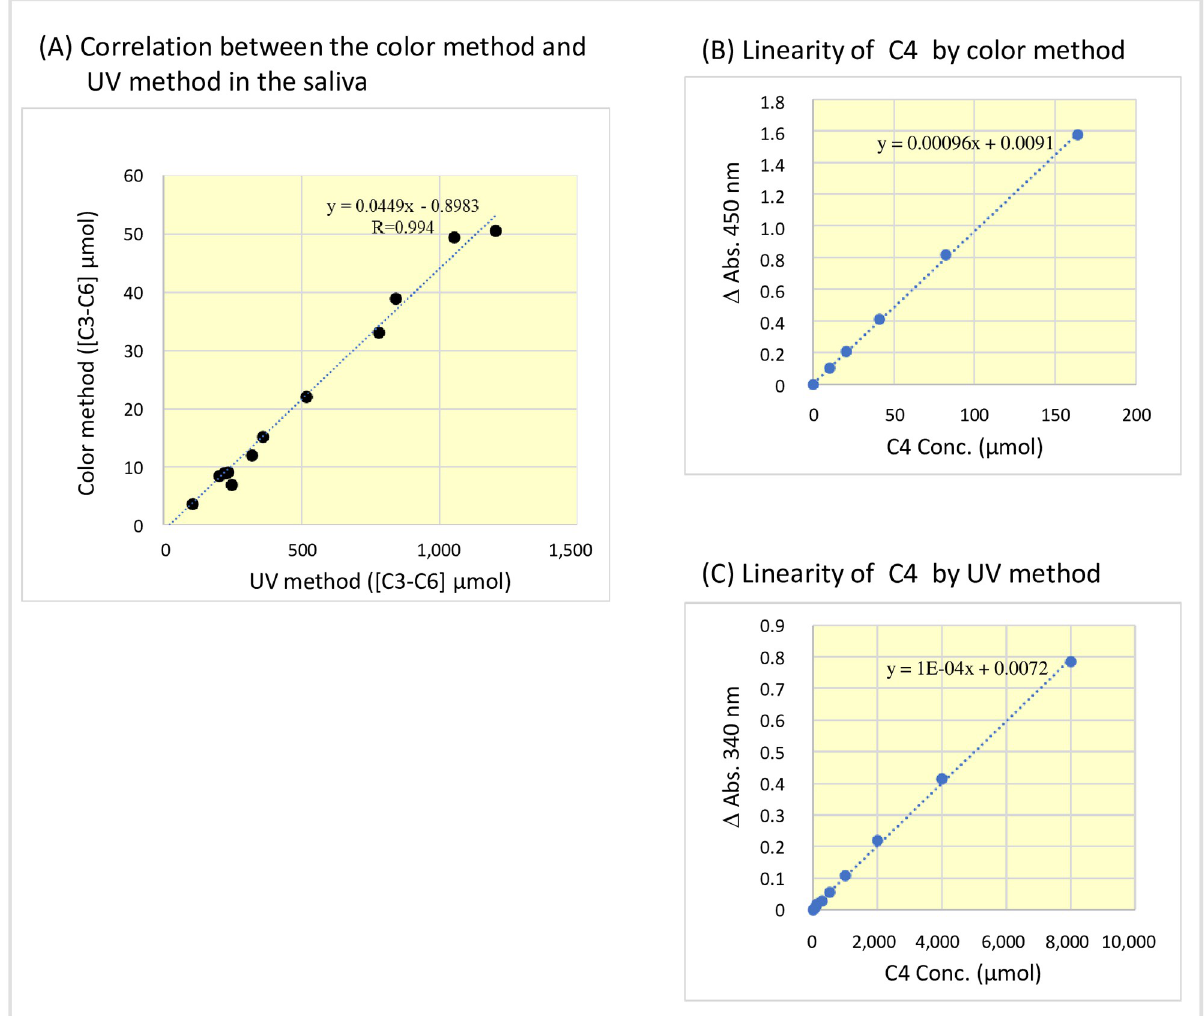
Fig 1. Correlation between color method and ultraviolet rays method for [C3-C6] assay in the saliva and calibration curves for C4 obtained by these methods. (A) Correlation between the vales obtained by color method and ultraviolet rays method for [C3-C6] standards. Since the color method is highly sensitive, saliva was diluted 20-fold with physiological saline for measuring. (B) Linearity of C4 calibration curve using the color method. (C) Linearity of C4 calibration curve using the ultraviolet rays method. [C3–C6], propionic acid, butyric acid, isobutyric acid, valeric acid, isovaleric acid, and caproic